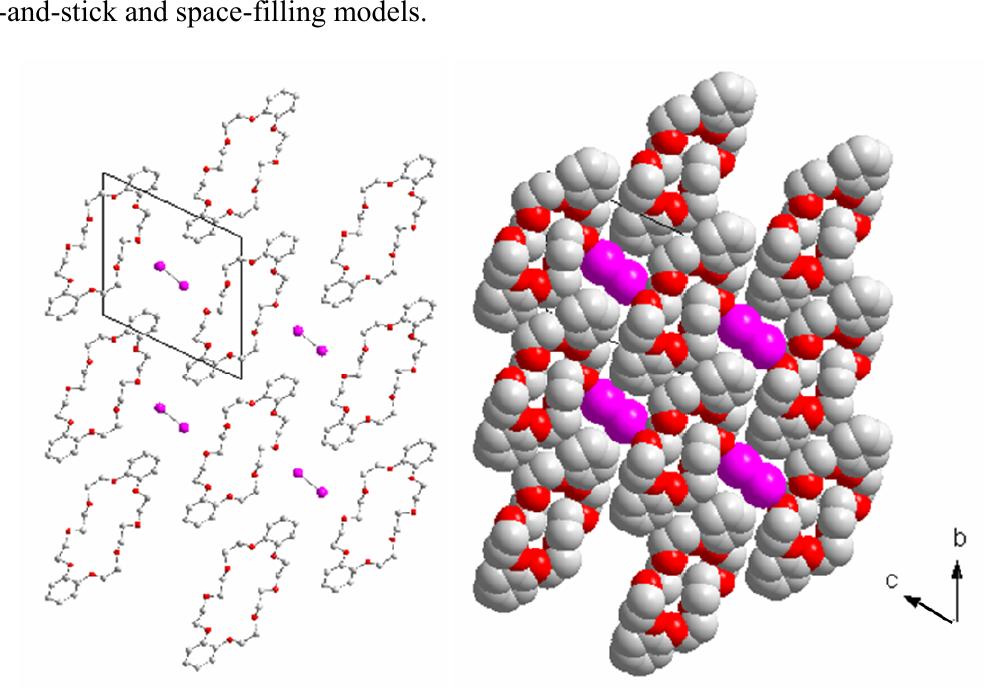
)@(db24c8) down [100]; 2